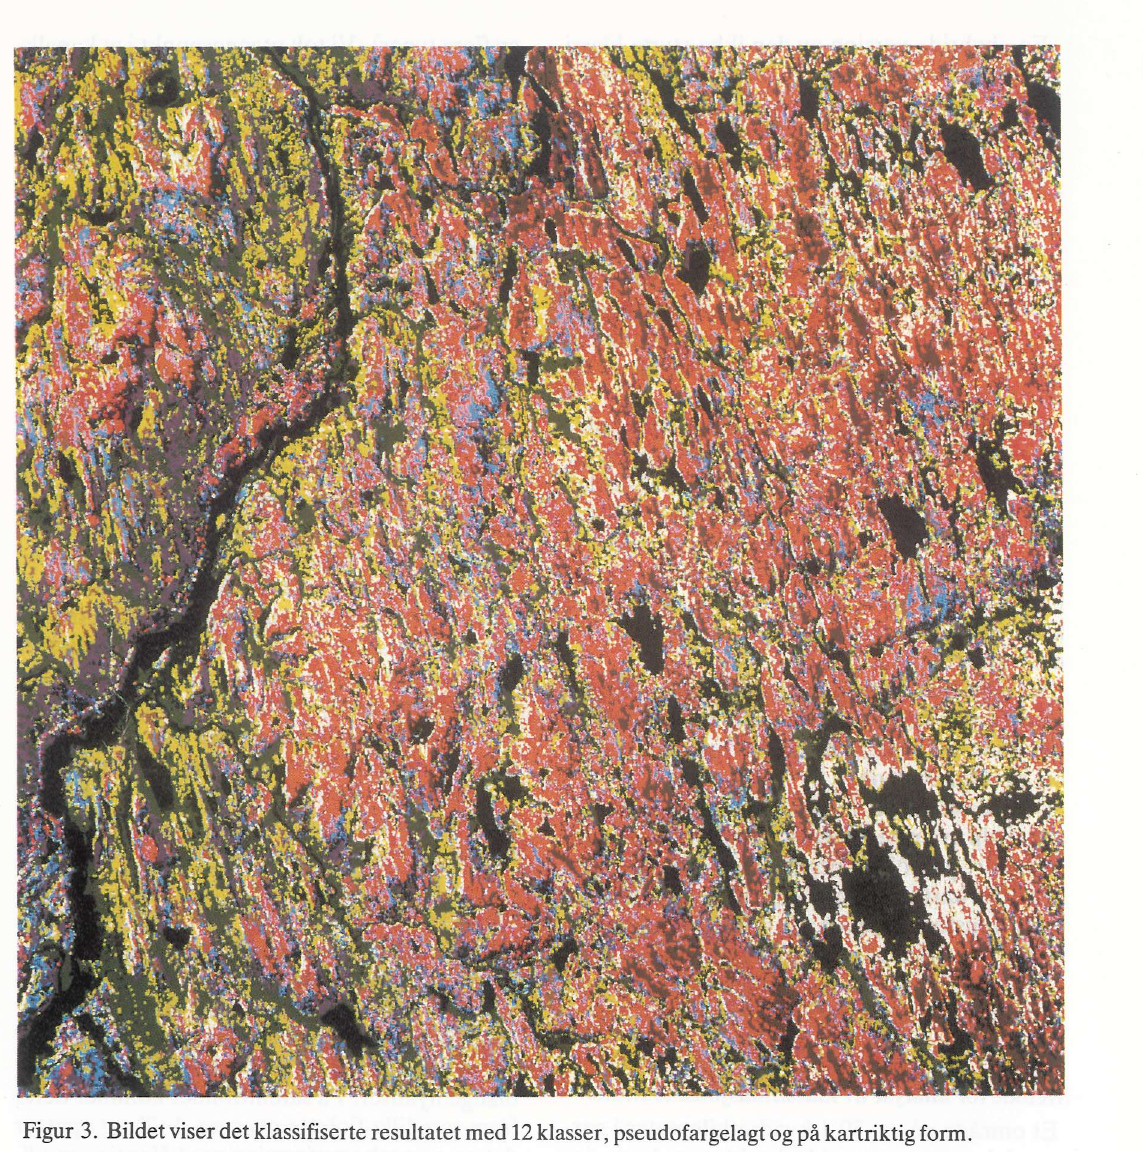
Fig. 3. The final result, pseudo coloured thematic map over the whole area. The legend comprises 12